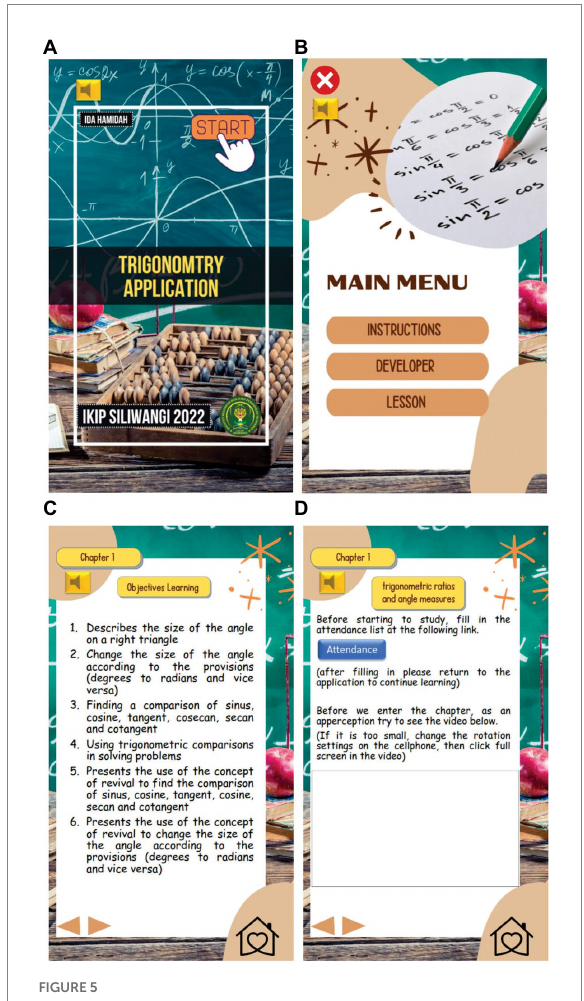
FIGURE 5 Interface design (A) homepage, (B) default menu page, (C) learning goals, and (D) attendance links.